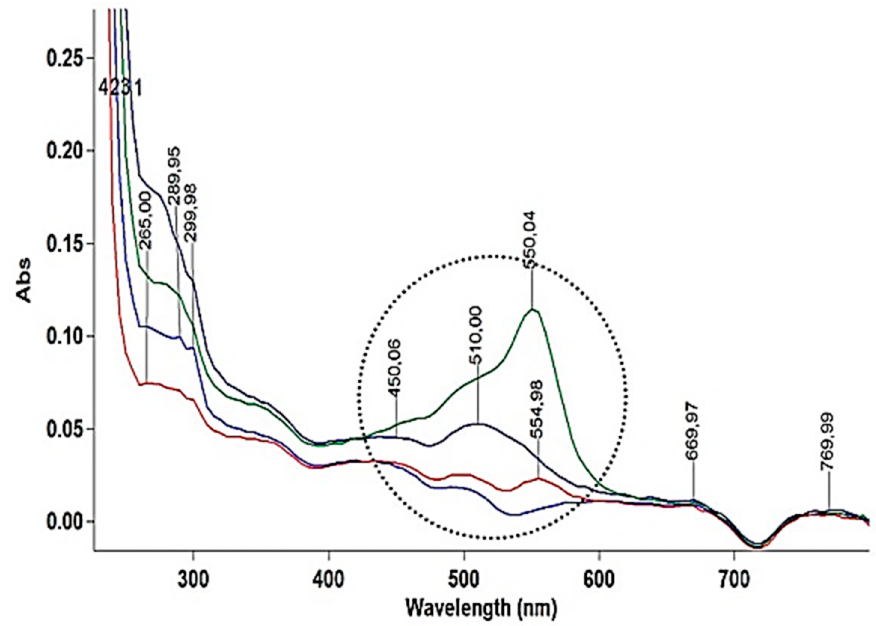
Figure 9. UV-Vis absorption spectrum of silk warps: 1-Sample 5 (Fragment 1), 2-Sample 7 (Fragment 2), 3-Sample 1 (Chasuble), 4-Sample 3 (Velum). A peak of yellow orange tone λ max 415 and 495 nm characterises Sample 9 and 10 of the subsequent interventions (Figure 10).